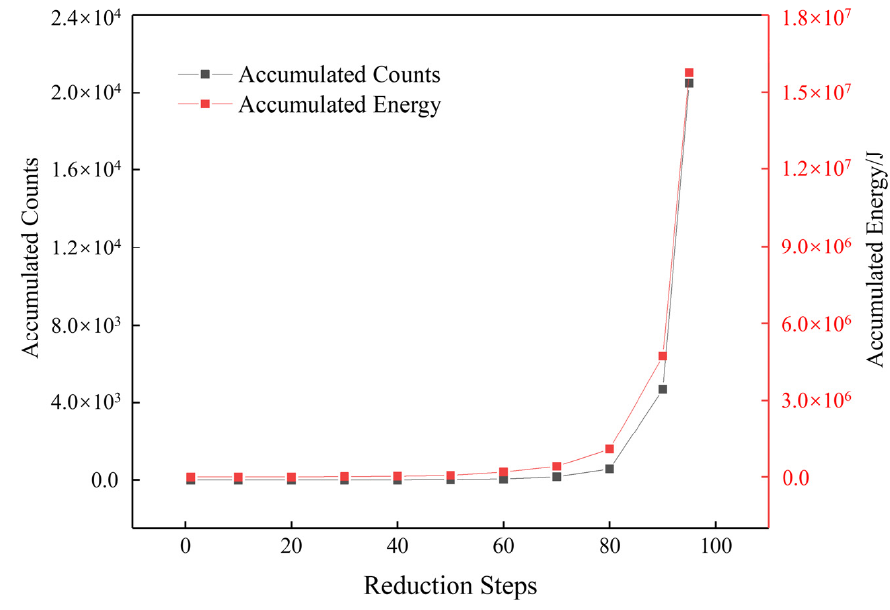
Figure 16. Accumulated acoustic emission counts and energy.